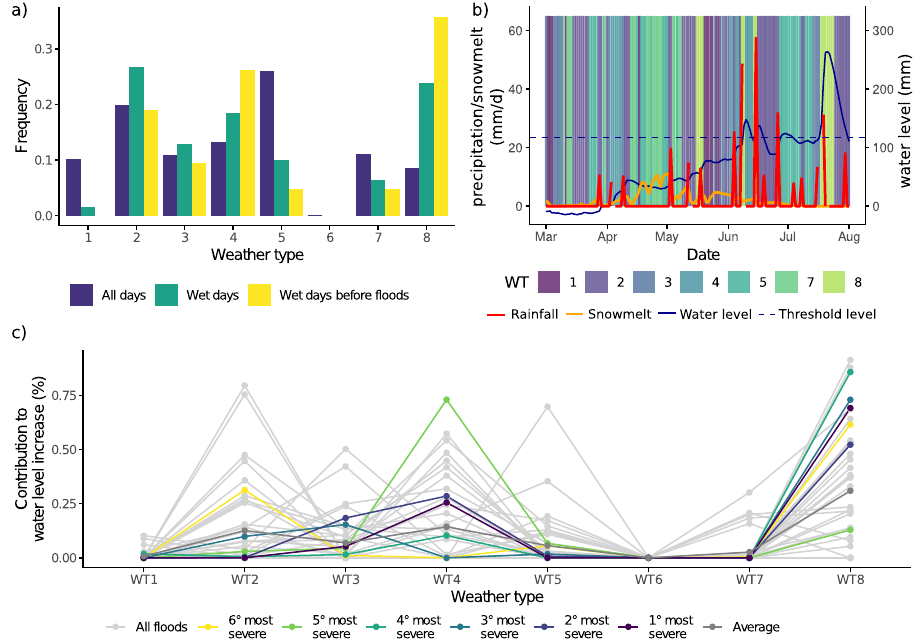
Fig. 6 Analysis of weather patterns associated with the rainfall events triggering lake fl oods. a Frequency of the weather circulation types, identi fi ed by the LaMMa Consortium, during all days in the record, wet days, and days in which the last rainfall event preceding a fl ood occurred. b Daily total rainfall and snowmelt over the basin and lake water level during the period preceding the fl ood of July 1987. The horizontal dashed blue line represents the water level above which fl ooding of Como occurs. The colours in the background identify the daily weather patterns. c Contribution of the eight weather types in the increase of water level due to rainfall clustering for each fl ood event. The six most severe events are highlighted along with the average